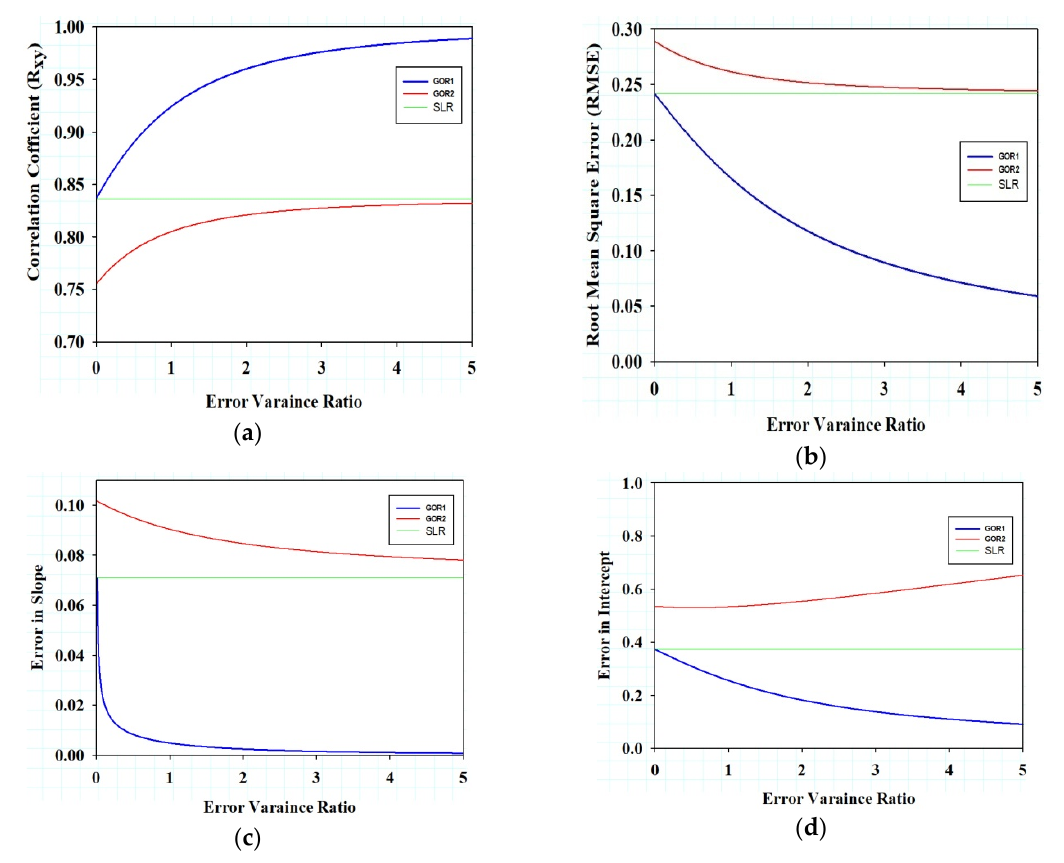
Figure 8. Comparison of the uncertainty in regression parameters for (m b,ISC − M wg ) data pairs using GOR1, GOR2, and SLR approaches considering the function of error variance ratio: ( a ) Correlation Coefficient determination (R xy ), ( b ) Root mean square error (RMSE), ( c ) uncertainty values of slope and ( d ) uncertainty of intercept.